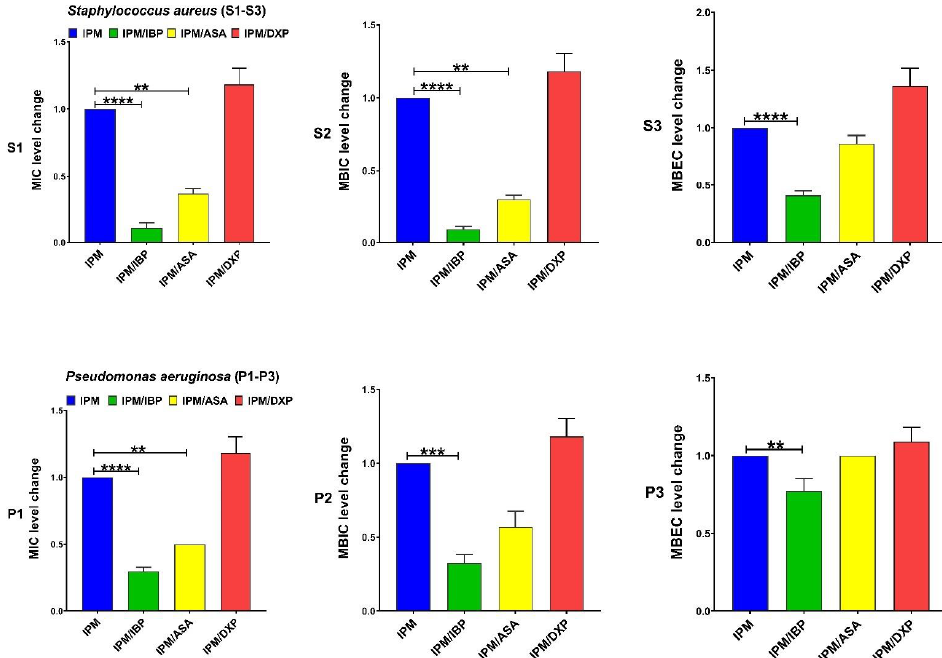
Figure 3. Effects sub-MICs of ibuprofen (IBP: 200 µ g/mL), aspirin (ASA: 200 µ g/mL), and dexamethasone sodium phosphate (DXP: 500 µg/mL) on the level of MIC, MBIC, and MBEC of imipenem (IPM) for clinical isolates. Graphs were drawn based on fold changes of MIC, MBIC, and MBEC for IPM in combination with sub-MICs of IBP, ASA, and DXP on clinical isolates. Data are displayed as the mean ± standard error of the mean from 3 replicate experiments and were analyzed using ANOVA and nonparametric Kruskal – Wallis test (S1 – S3 for S. aureus isolates and P1 – P3 for P. aeru- ginosa isolates) . IBP significantly decreased the levels of MIC, MBIC, and MBEC for IPM among both clinical isolates of S. aureus and P. aeruginosa. ASA significantly decreased the level of MIC for IPM among both clinical isolates and MBIC for IPM among S. aureus isolates. DXP did not significantly affect the MIC, MBC, and MBEC for IPM among both clinical isolates. **, statistical significance with p ≤ 0.01; ***, statistical significance with p ≤ 0.001; and ****, statistical significance with p ≤ 0.0001.